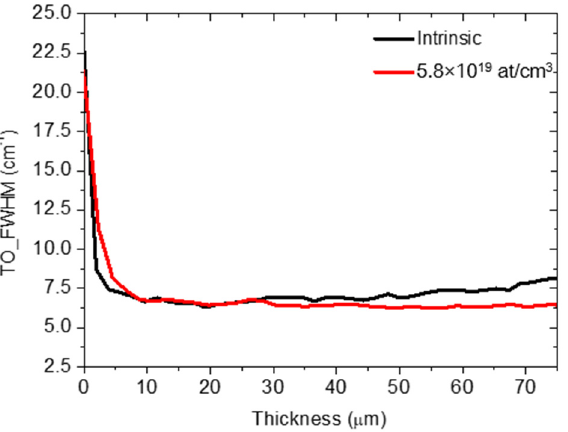
Figure 7. FWHM of the TO peak vs. 3C-SiC thickness in cross-section for intrinsic and 5.8 × 10 19 at/cm 3 (red line) samples. The zero value on the X-axis corresponds to the removed interface with the silicon.